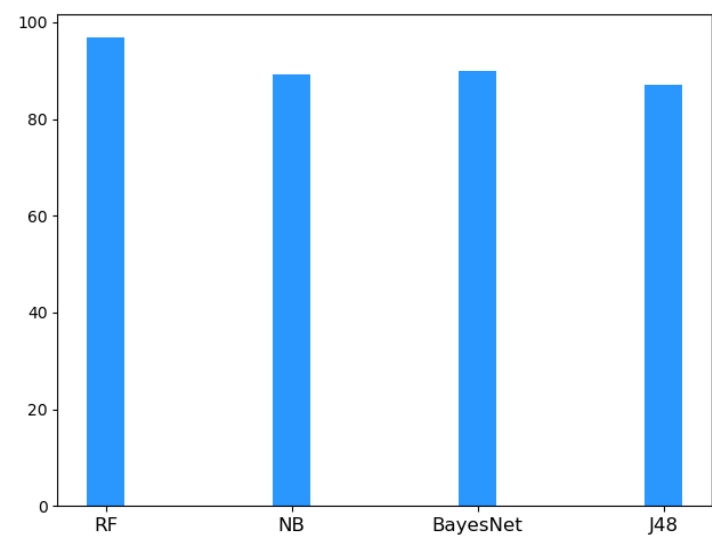
Figure 10. Comparison of the deep features-based RF, naïve Bayesian, Bayesian network, and the J48. Y -Axis shows the F-measure.